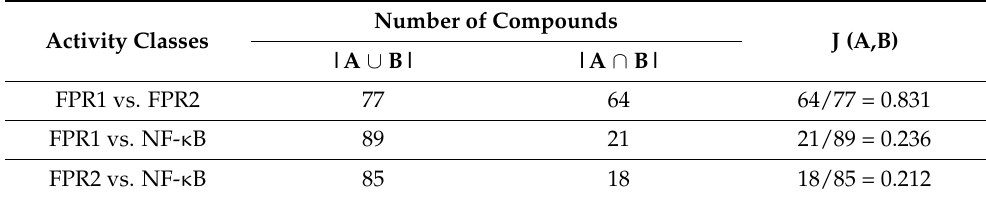
Table 5. Jaccard indices for different pairs of biological